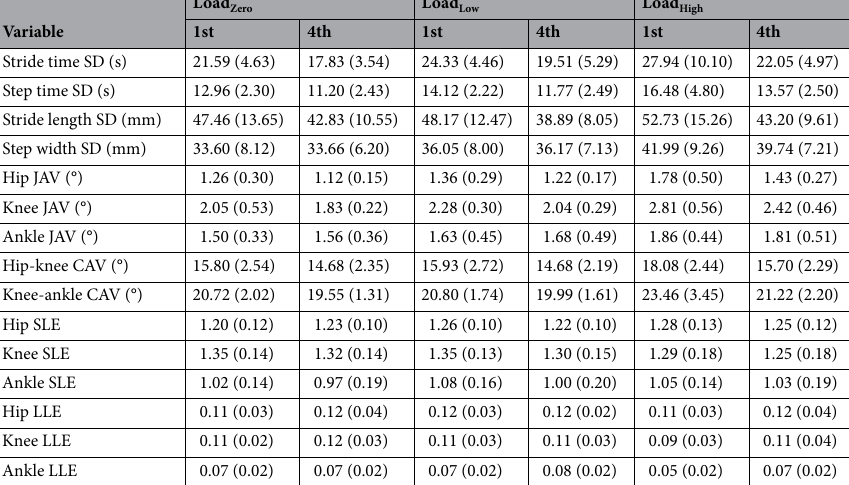
Table 4. Gait variability measures for each load condition and experience group. All values reported as means (SDs).